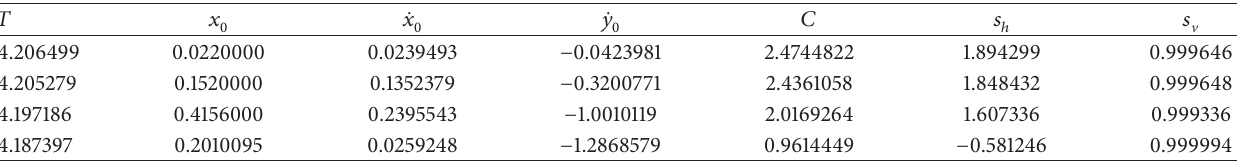
Table 3: Sample members of the short period family emanating from the triangular equilibrium point 𝐿 4 for 𝑞 1 = 0.5, 𝑞 2 = 0.8, 𝜔 = 1.5, and 𝜇 =